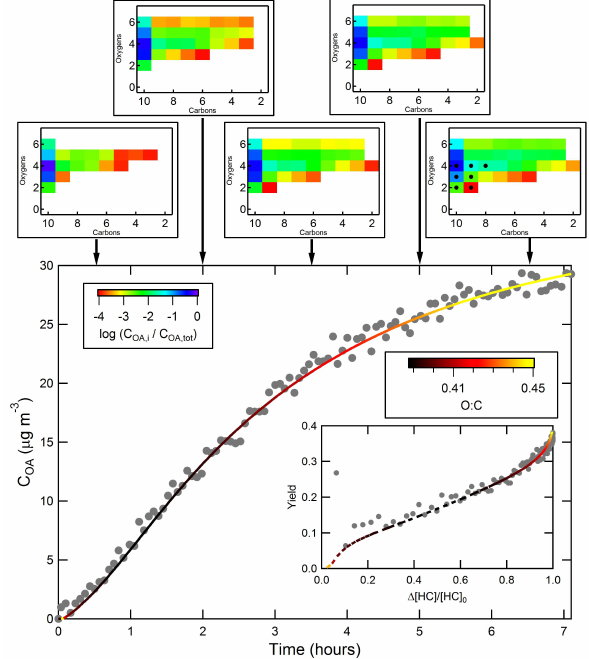
Fig. 8. (main graph) Time-dependent aerosol formation for α - pinene photooxidation under low-NO x conditions comparing the calculated curve (line) to observations (points) (Ng et al., 2007a). The calculated curve is colored by the mean O:C of the OA. (in- set) The aerosol growth curve (yield vs. 1 [HC]) for this system. (above) The small graphs show the distribution of products, colored by mole fraction in the condensed phase, at various points through- out the reaction (indicated by arrows) in oxygen/carbon space. The points in the upper-right graph indicate structures for compounds that have been observed to exist in the condensed phase with mea- surable